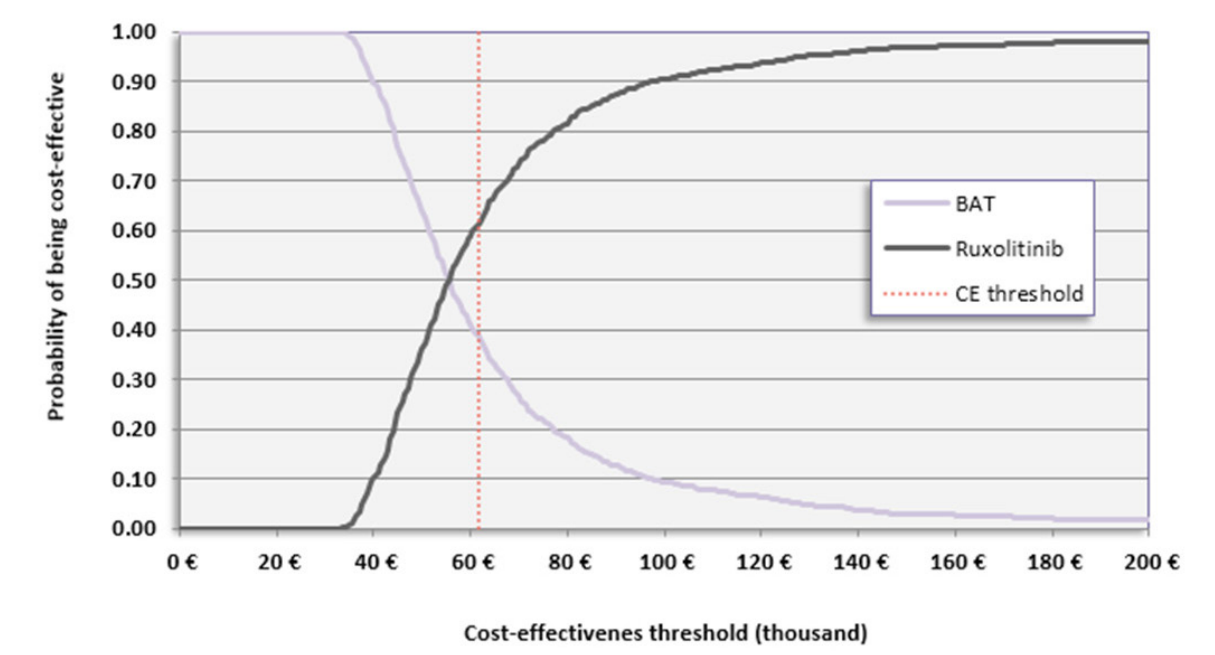
Figure 4. Cost-effectiveness Curves (probability of being cost-effective according to the